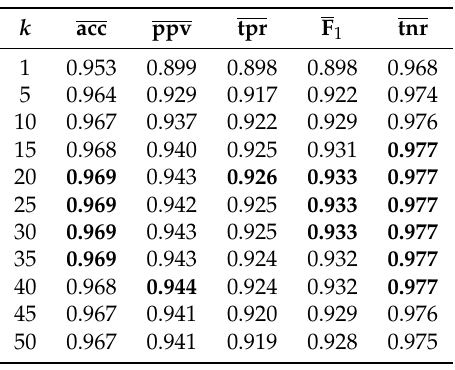
Table 4. Performance measures (per-unit) for the k NN method using different number of nearest neighbors ( k ). The cases with the best performance of each measure are highlighted in bold.